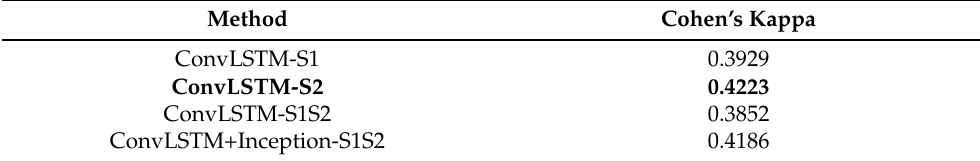
Table 6. Cohen’s Kappa for each method for 6 semantic classes (In bold the best method).